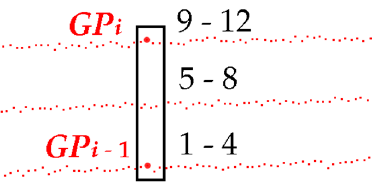
Figure 5. Scanning frequency test area.